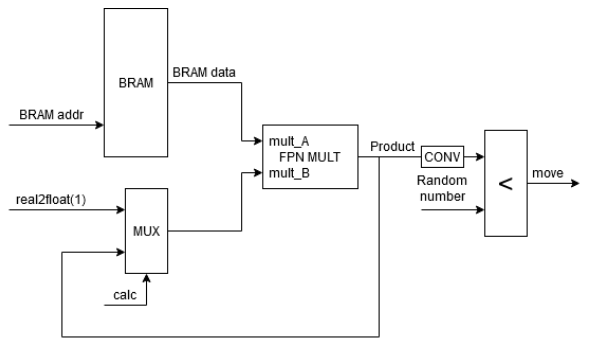
Figure 4. Block diagram of a module that implements the kinetic Monte Carlo